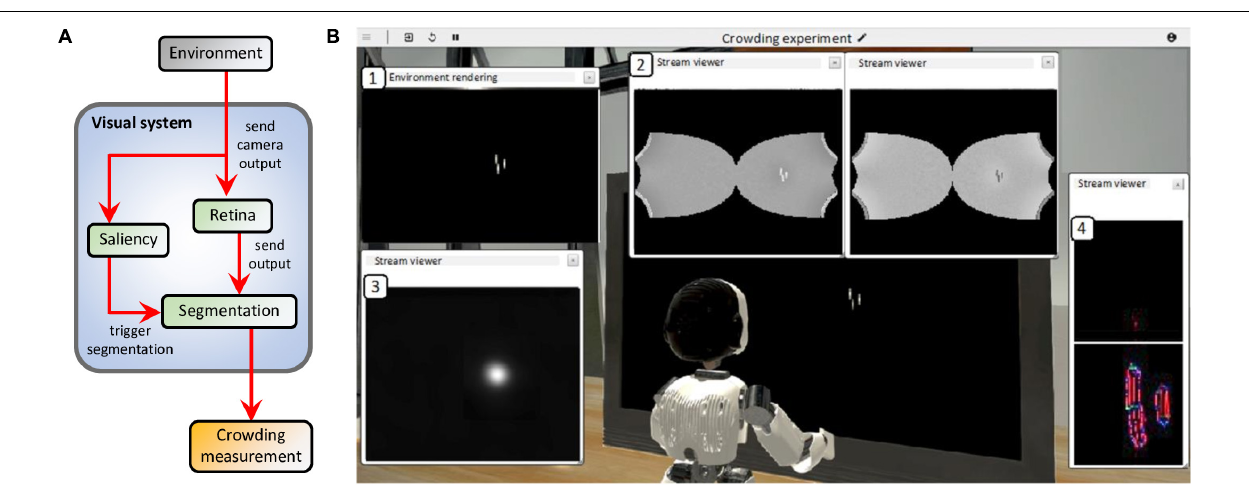
FIGURE 7 | (A) Model interactions in the visual system (blue box) of the robot. The camera of the right eye of the robot processes the visual environment (gray box) and sends a gray-scale input image to both the retina and the saliency models. The retina model sends its output, i.e., the contrast-related activity of ON- and OFF-centered ganglion cells, to the input layer of the segmentation model. The saliency model delivers its output to the segmentation model as a 2-dimensional probability density distribution that determines where each selection signal (such as the blue circle in Figure 4 ) starts the segmentation dynamics, whenever the visual stimulus appears to the robot’s eyes. Finally, a threshold measurement (yellow box) is computed from the segmentation model’s output. Since neither the robot nor the robot’s eyes move, there is no arrow going from the visual system to the environment. (B) Example of the result of the simulation of the visual system for one segmentation trial. In this example, the environment of the robot reproduces one of the conditions of the paradigm that measures inward-outward anisotropy in visual crowding in Manassi et al. (2012; see Figure 3A ). All displayed windows are interactive visualizations of the output of the models that constitute the visual system (see A ). They can be displayed while the simulation is running. (1) Output of the camera of the right eye of the robot, which is fed to the retina and the saliency models. (2) Output of the retina model (ON- and OFF-centered ganglion cells, respectively on the right and on the left). (3) Output of the saliency model. The visual stimulus is very salient (white spot). (4) Output of the segmentation model. Each slot of the segmentation model’s output corresponds to a different segmentation layer (as in Figure 4A , except SL 0 and SL 1 are above and below here). The intensity of each pixel corresponds to the activity of an orientation-selective neuron encoding the stimulus as a local feature detector. The color of the pixel represents the orientation of the most active neuron at that location (red: vertical, green: horizontal, blue: diagonal, and turquoise or purple: intermediate orientations). The output associated to the stimulus is not a straight vertical line, as in Figure 4A , because the input of the segmentation model is distorted by the retina model. Here, the segmentation has not been successful, because the target and the flankers end up in the same segmentation layer. This means that at stimulus onset, the segmentation signal drawn from the saliency distribution overlapped with both the target and the flanker, spreading the segmentation to the whole